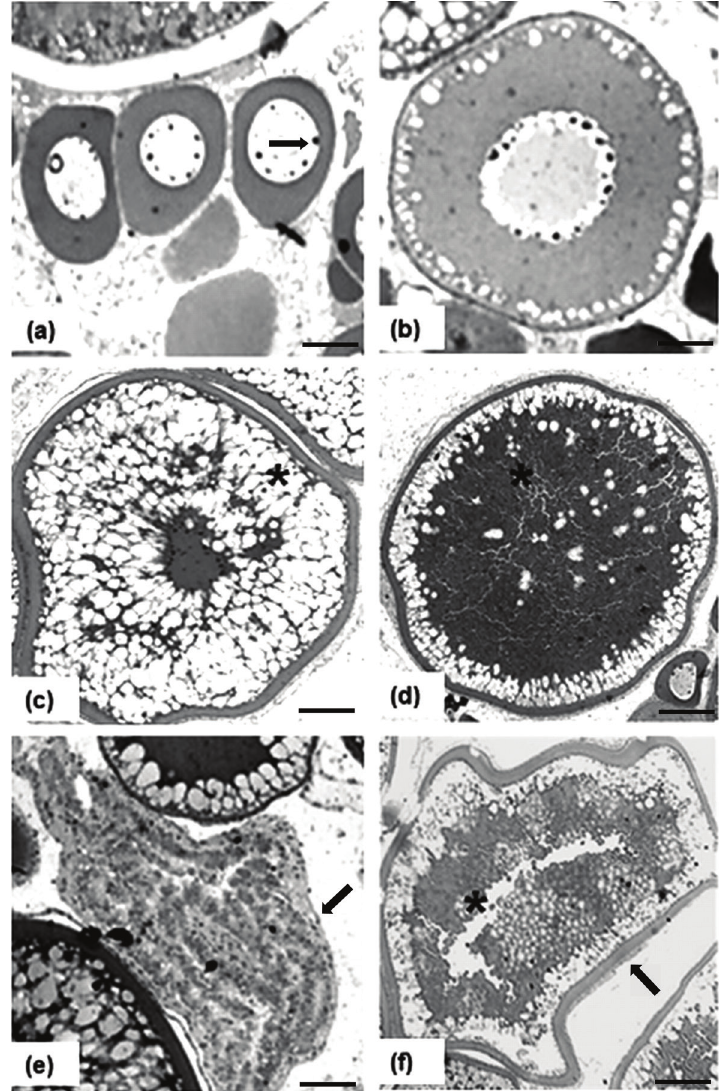
Fig. 2. Photomicrographs of different oocyte types observed during the Metynnis maculatus reproductive cycle. (a) Previtel- logenic oocytes showing multiple nucleolus (arrow), (b) Cortical alveoli oocyte; (c) Early vitellogenic oocyte with cytoplasm filled mostly with cortical alveoli (asterisk); (d) Final vitellogenic oocyte with cytoplasm completely filled with protein yolk granules (asterisk); (e) Post ovulatory follicles with numerous border folding (arrow), (f) Atretic oocytes with fragmented vitel- line membrane (arrow) and a change in the appearance of the cytoplasm (asterisk). Hematoxylin-floxin. Scale bar = 100